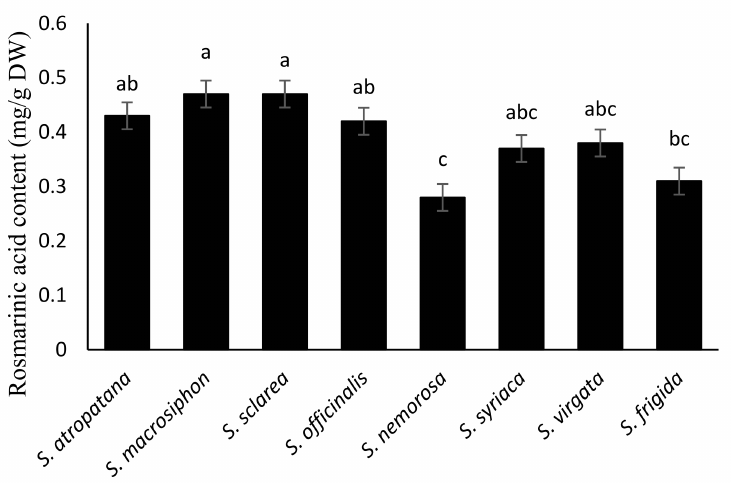
Figure 3. Comparison of rosmarinic acid content in leaves of Salvia species. Different letters over bar indicates significant difference in treatment according to Duncan’s multiple range test ( p <